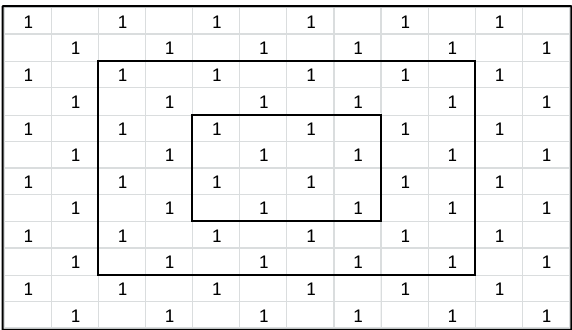
Figure 4. An example of q ’s relationship with density, n . As the point intensity decreases, an accompanying decrease in grid size is required to give the same spatial distribution. However, due to the “smoothening effect”, the GSE increases slightly with increasing point intensity also in this example.